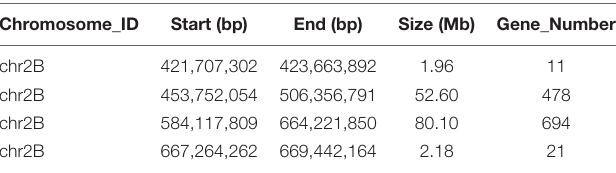
TABLE 2 | The candidate intervals of the R gene PmYD588 and gene numbers in these intervals using the Euclidean distance (ED) algorithm.